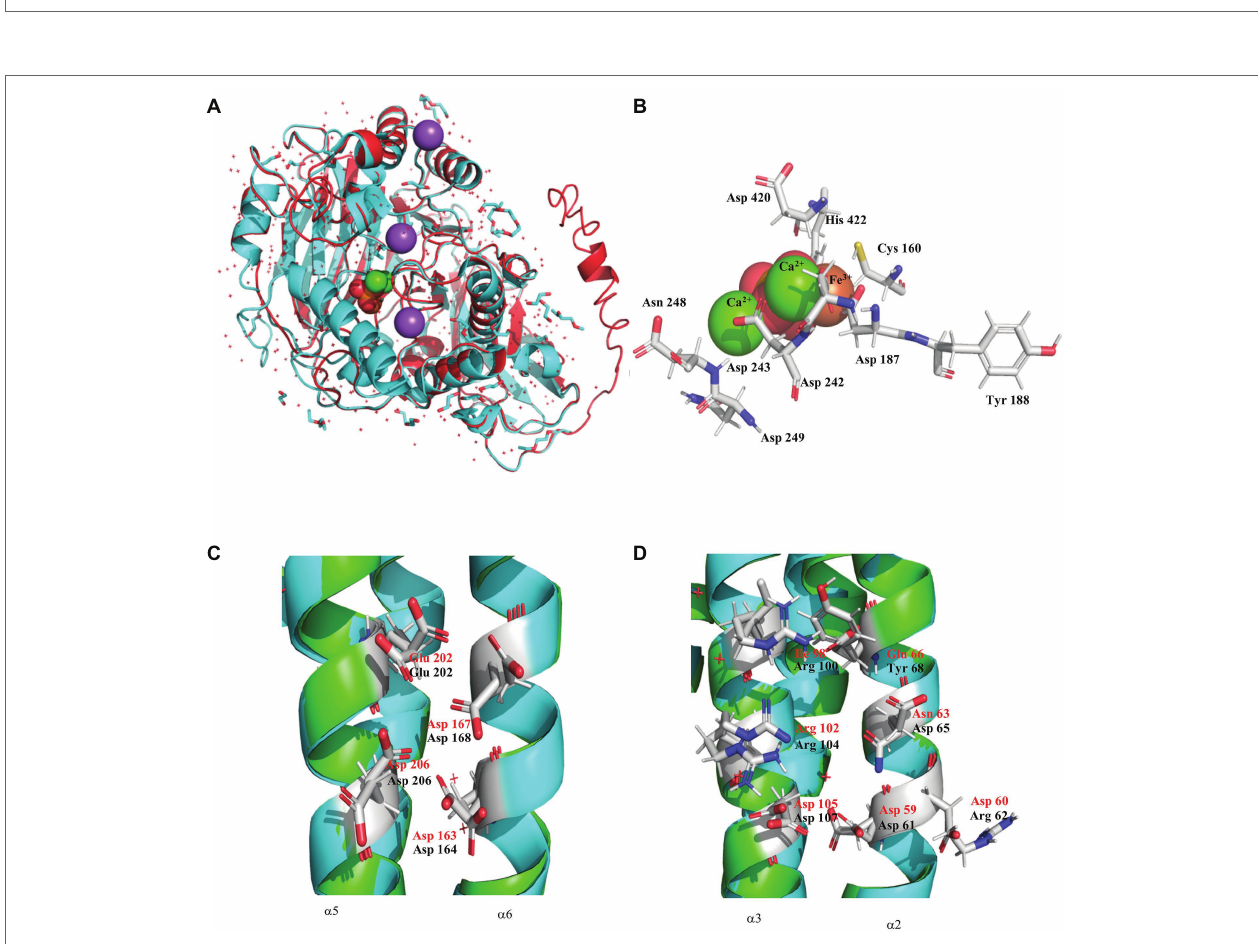
FIGURE 2 | Structural analysis of PhoD and PhoU of Halothece sp. PCC 7418. (A) Predicted structure of PhoD of Halothece sp. PCC 7418 is represented in red and aligned with the crystal structure 2YEQ that is displayed in blue cyan. (B) Active center of PhoD of the test bacterium showing all the aminoacids involved in coordination with two Ca 2+ and Fe 3+ ions. (C) Cluster 1 of PhoU, trinuclear metal site with Fe, between α 5 and α 6. (D) Cluster 2 of PhoU, tetranuclear metal site with three Fe and one Ni, between α 2 and α 3. Black amino acids are from predicted PhoU and red amino acids are from 4Q25. All the structures were represented with Pymol.